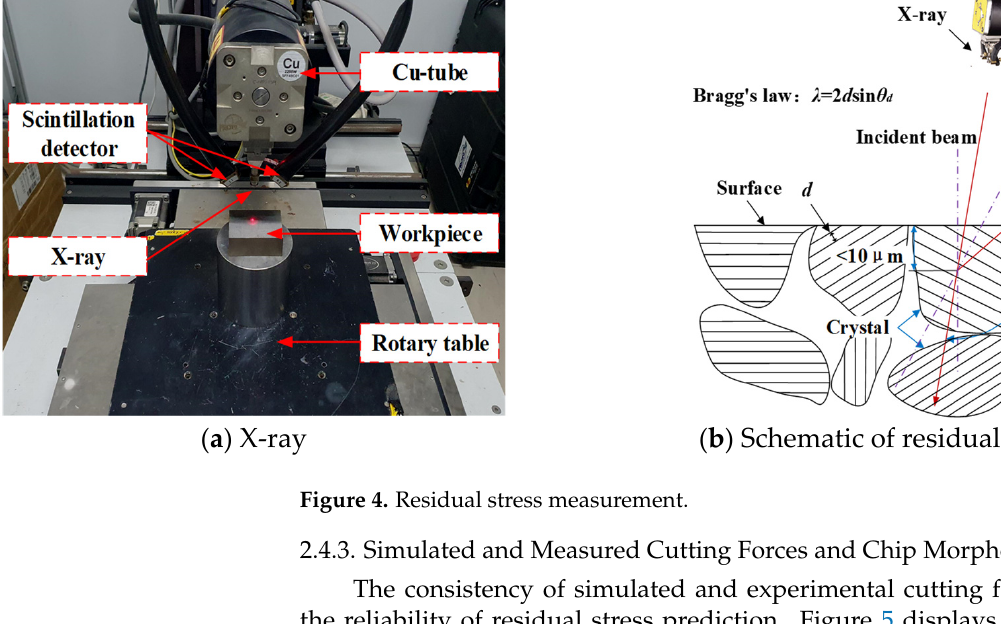
( c ) Figure 5. Experimental and simulated cutting forces: ( a ) θ = 35°, V c = 100 m/min, f z = 0.05 mm/rev; ( b ) θ = 55°, V c = 100 m/min, f z = 0.09 mm/rev; ( c ) θ = 75°, V c = 100 m/min, f z = 0.03 mm/rev.